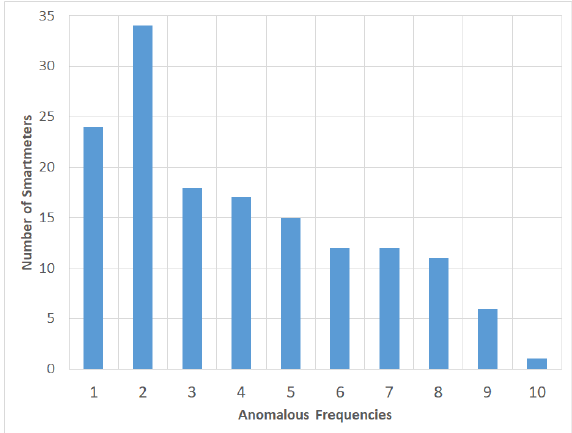
Figure 5. Observation of the frequency anomalous events from the total 150 smart